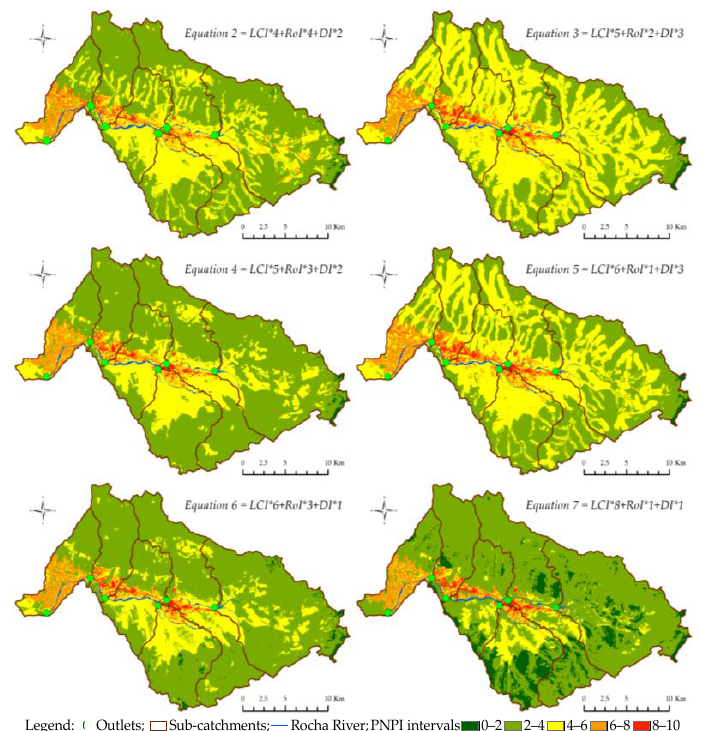
Legend: !( Outlets; Sub-catchments; Rocha River;PNPI intervals 0–2 2–4 4–6 6–8 8–10 Figure 12. Spatial distribution of potential non-point pollution index (PNPI) classes in the Rocha River catchment in 1997, calculated from Equations (2)–(7). Water 2021 , 13 , x FOR PEER REVIEW